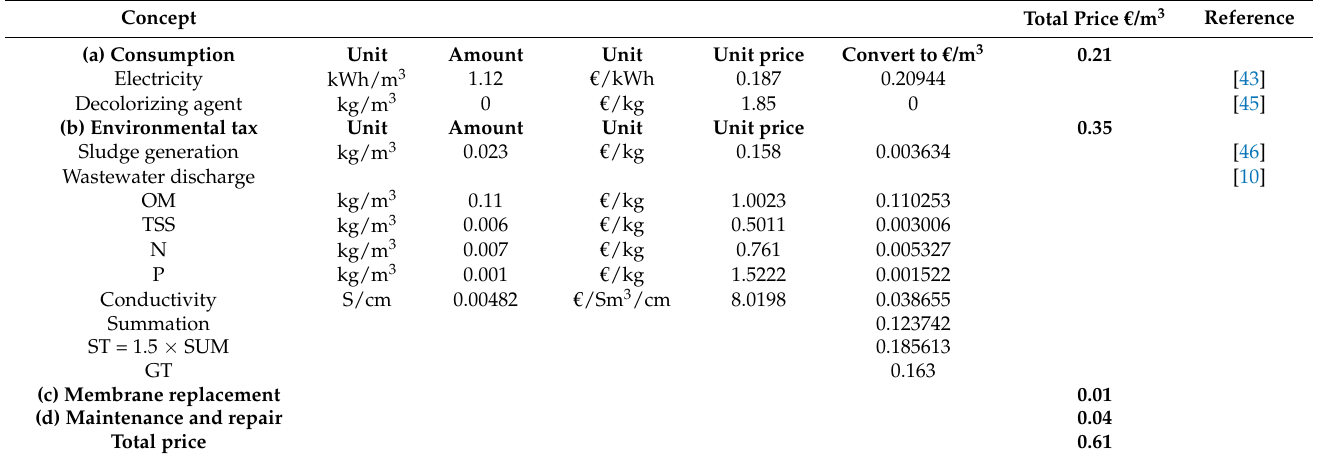
Table 7. MBBR-MBR operational cost for treating 1 m 3